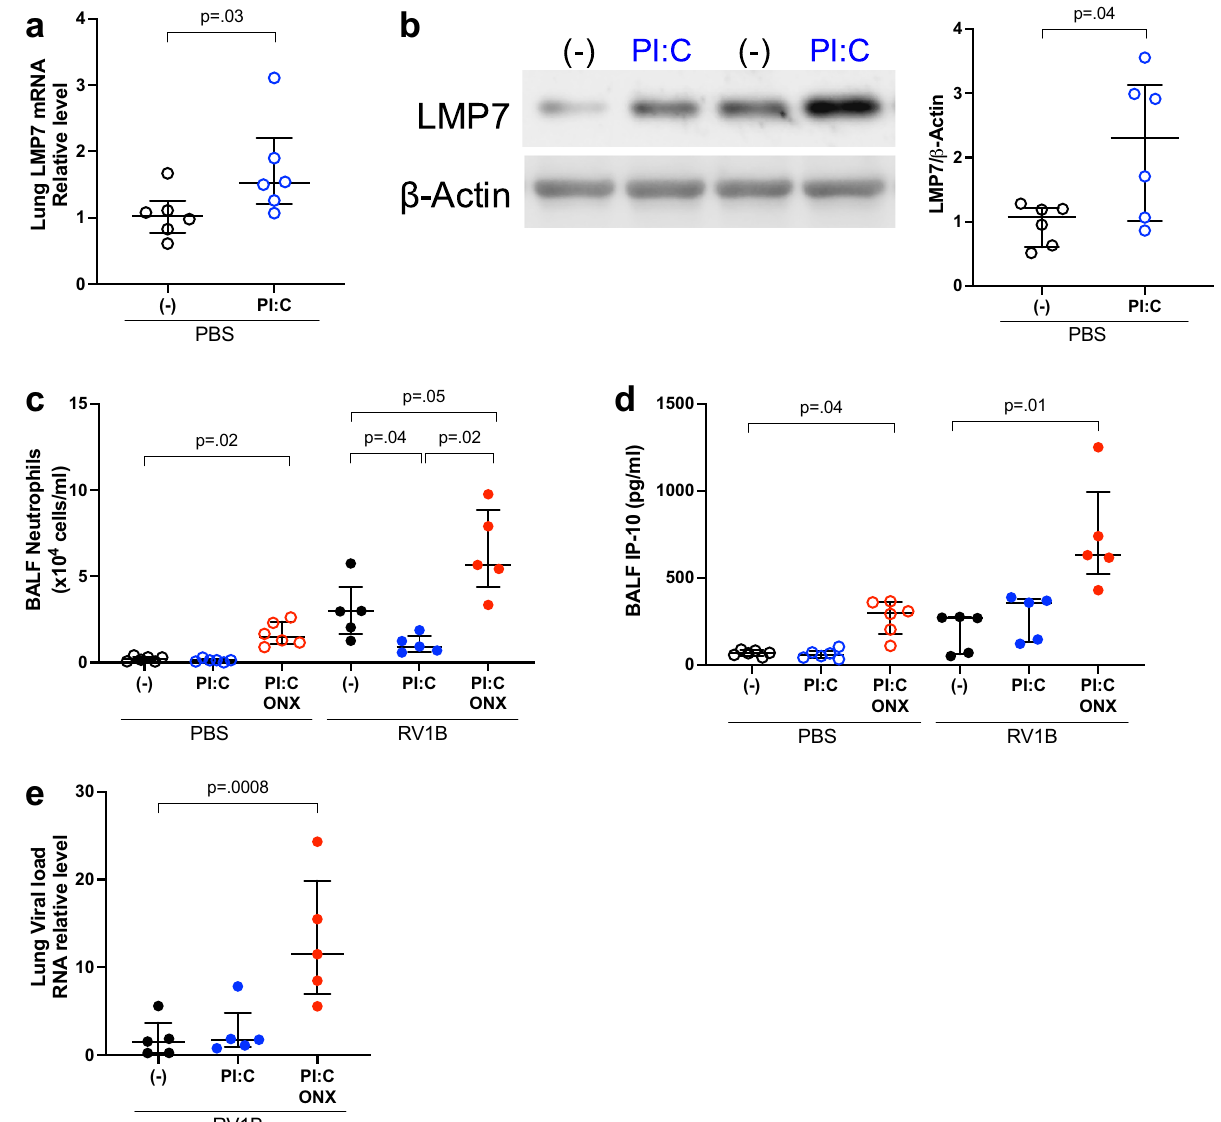
Figure 4. A low dose of PI:C reduces neutrophilic inflammation in wild-type (WT) mice infected with RV1B . Mice were pre-treated with 2 μg/mouse PI:C or PBS intranasally. At 20h post PI:C treatment, mice were challenged with ONX-0914 at 5 mM/mouse or 0.5% DMSO-PBS via oropharyngeal administration for 4h followed by intranasal inoculation of RV1B at 5 × 10 6 PFU/mouse or 0.1% BSA-PBS (PBS). Mice were sacrificed at 24h post infection. ( A ) LMP7 mRNA relative levels from individual mouse lungs were normalized to 18S rRNA gene. ( B ) Representative western blot image and densitometry of LMP7 protein. ( C ) Total number of neutrophils in BALF. ( D ) IP-10 levels in BALF. ( E ) RV load was measured in the lung by RT-qPCR and normalized to 18S rRNA gene. Data were analyzed using Mann–Whitney test ( A , B ) and Kruskal–Wallis test with Dunn’s multiple comparison test ( C – E ). n = 5–6 mice per